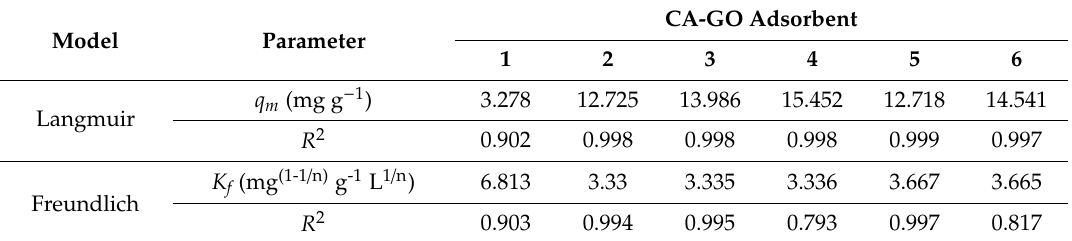
Table 3. Models of Langmuir and Freundlich for the adsorption of Ni 2 + at an initial concentration of 15 mgL − 1 .